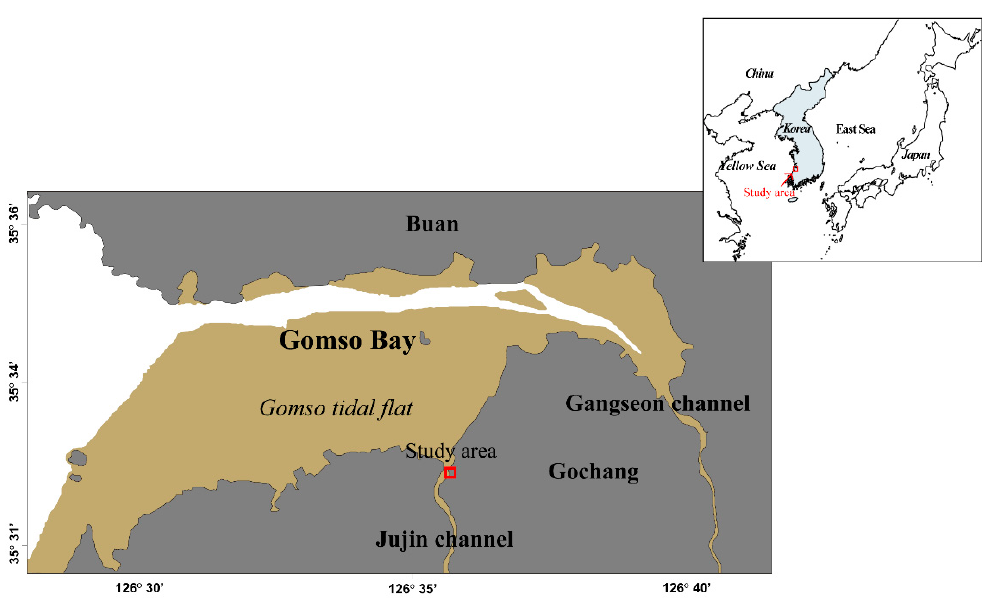
Figure 1. Location and layout of the study site in the Gomso tidal flat. Red rectangle represents study area; brown area represents tidal flat.